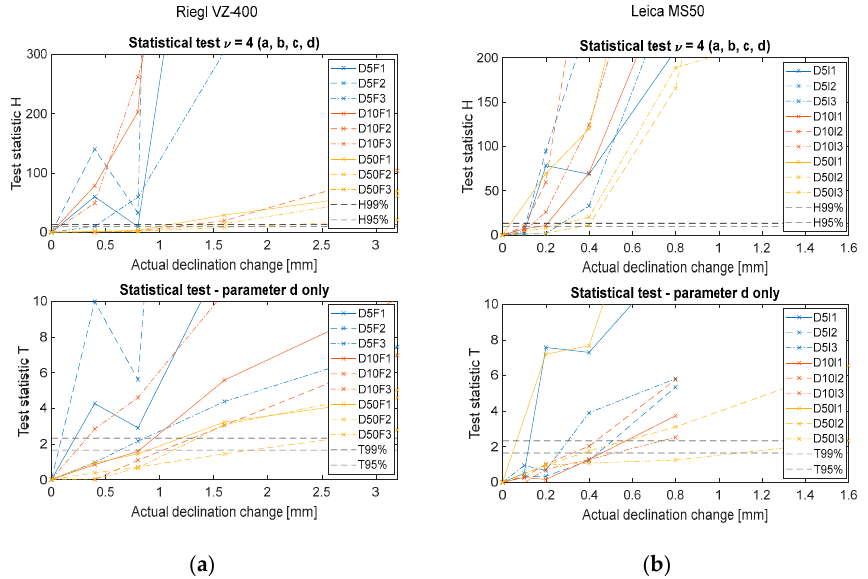
Table 2. The accuracy of detected shifting declinations: RMSE values.